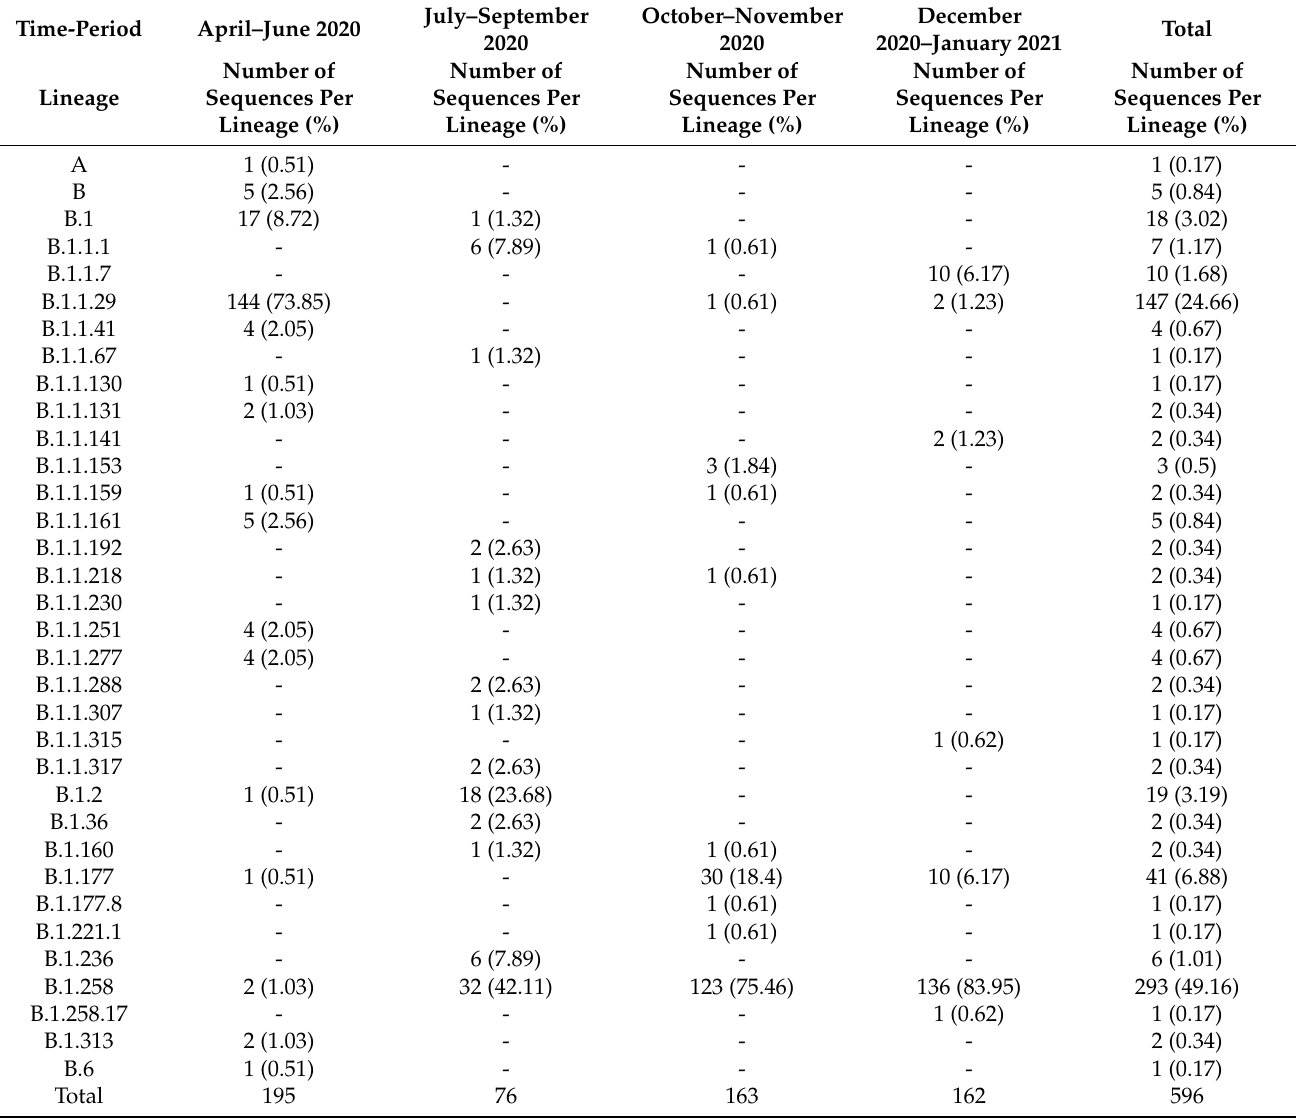
Table 1. SARS-CoV-2 lineages identified from 596 samples in Cyprus from April 2020 to January 2021.